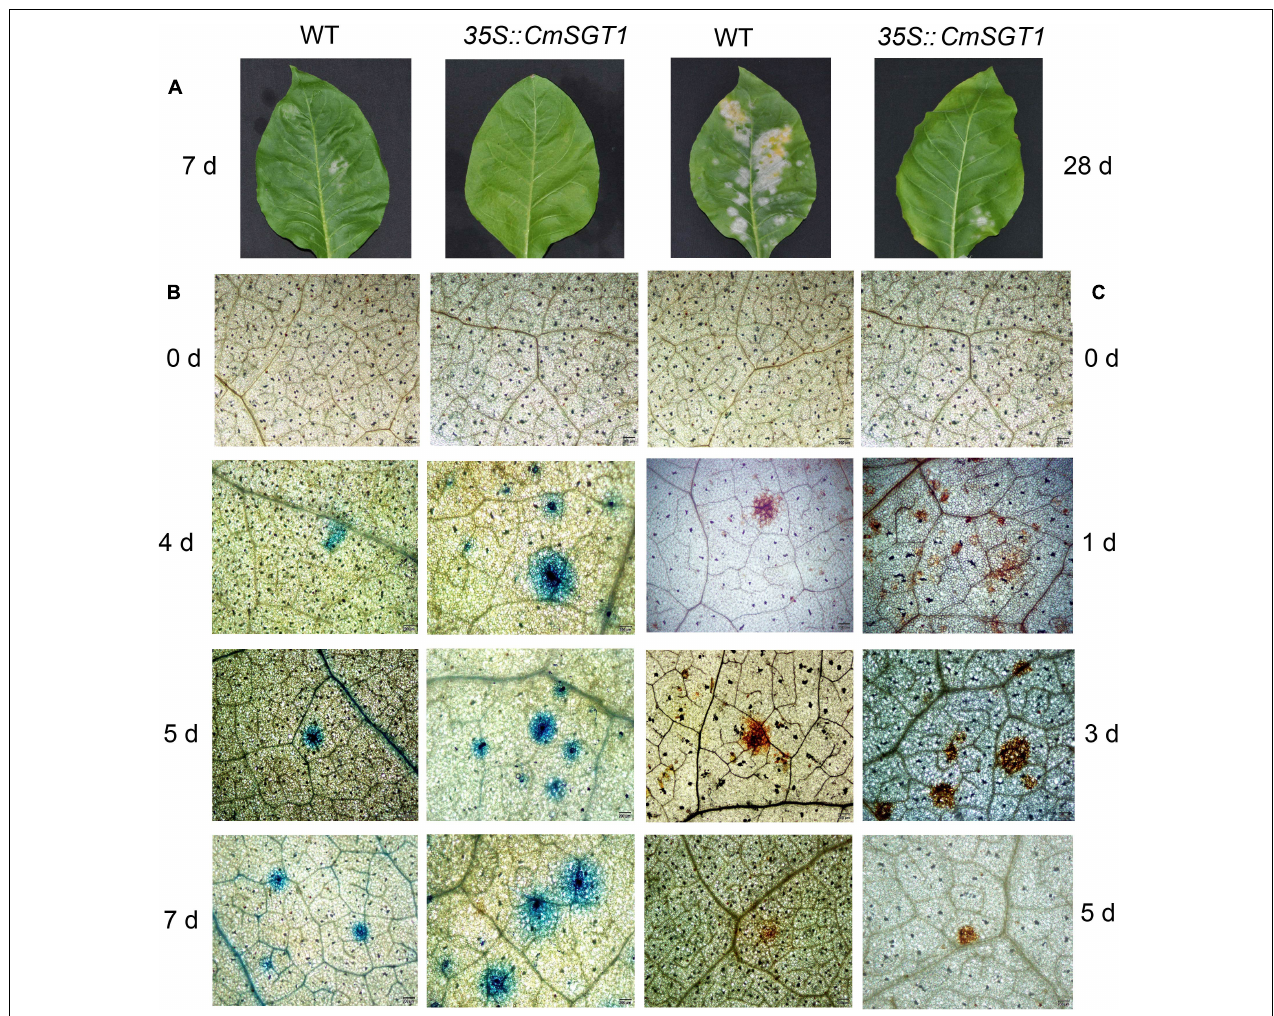
FIGURE 4 | The pathogenic symptoms, trypan blue and DAB staining of N. benthamiana leaves treated with powdery mildew. The pathogenic symptoms of transgenic N. benthamiana and WT at 7 and 28 days post-inoculation (A) ; trypan blue staining was performed to visualize cell death (B) ; DAB staining was performed to visualize H 2 O 2 accumulation (C) . Scale bars = 200 µ